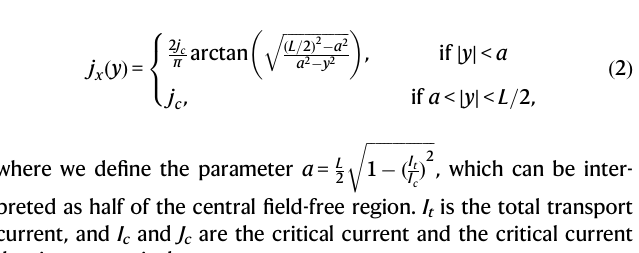
Fig.3|Correlationbetweenthevortexdiodeeffectandthemagnetictextureof EuS. a Asymmetry factor Δ I c = ∣ I + c ∣ (cid:2) ∣ I (cid:2) c ∣ as a function of magnetic fi eld for trans- verse (blue symbols) and longitudinal (red symbols) magnetization. The arrows mark the magnetic fi eld sweepdirections. b n-plane M(H) curve of anunpatterned EuS/Nb fi lm with the same thicknesses as our device. c – h SQUID-on-tip (SOT) images of the static out-of-plane (OOP) component of the magnetic fi eld B dc z ð x , y Þ emanating from the EuS/Nb bilayer under various applied in-plane (IP) magnetic